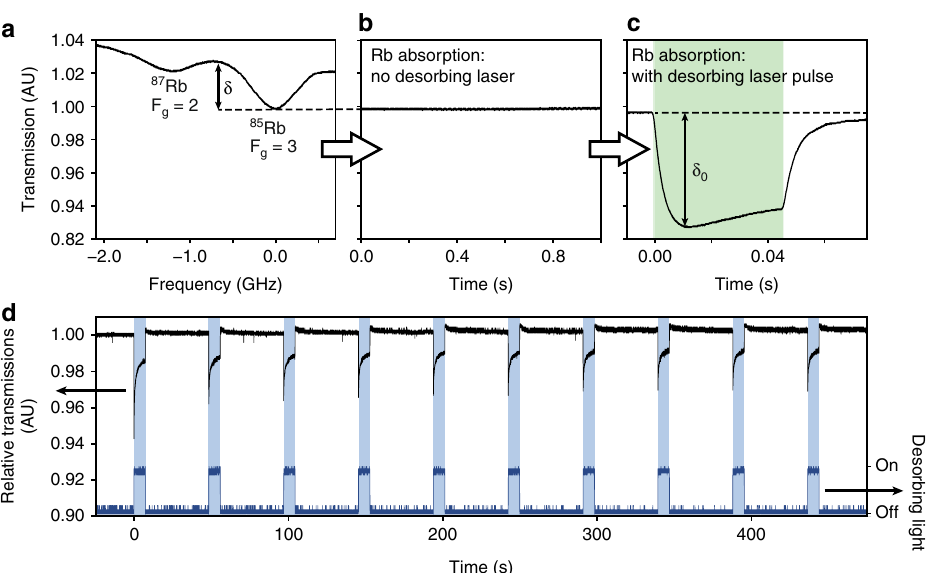
Fig. 3 Strong and reproducible increase in atomic cell vapor pressure upon illumination. a Doppler-broadened absorption spectrum of Rb D 2 line, obtained upon modulating the frequency of the DFB laser, at cell temperature of 17 °C. b Stabilizing the laser modulation at the F g = 3 transition of 85 Rb yields a constant light intensity signal. c A strong increase of absorption is observed upon illuminating the cell with 532 nm, 32 mW/cm 2 light for 45 ms. d For repeated illuminations with 406 nm, 31,5 mW/cm 2 light for 7 s (shutter in Fig. 2), the increased absorption is clearly reproducible. The initial peaks are due to bursts of desorbed atoms that subsequently migrate throughout the cell